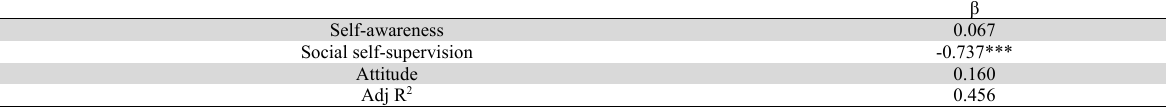
Attitude (A), social self-supervision (SS), and self-awareness (SA) as the predictors of aberrant driving behavior